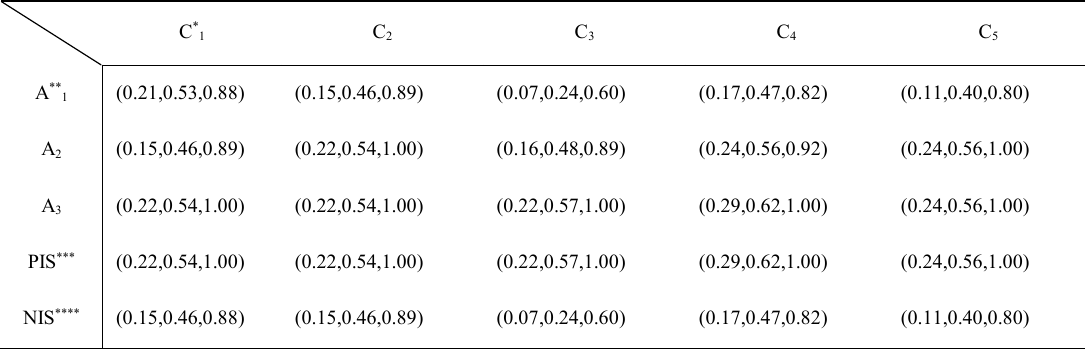
Table 4: Weighted normalized decision matrix